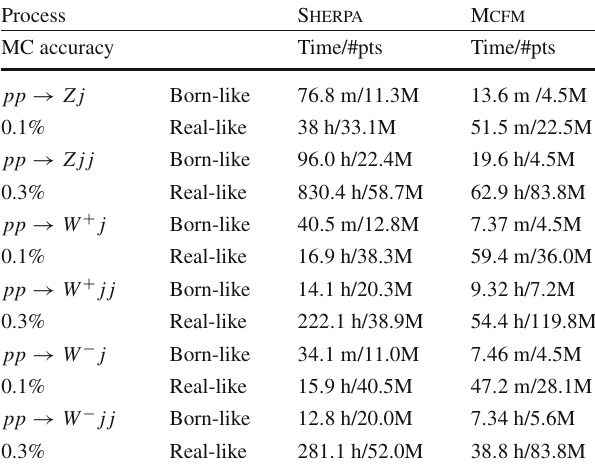
Table 4 Comparison of integration times using S HERPA and M